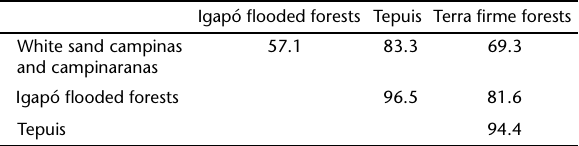
Table I. Number of bird species recorded in the terrestrial habitats in the Aracá region compared with the same habitats in better sampled places in the Amazon.